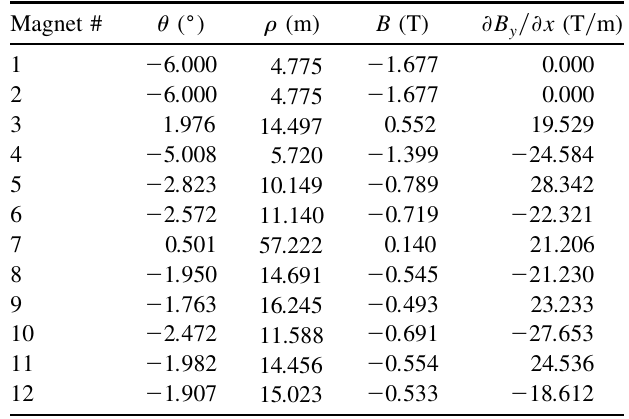
TABLE I. Bending angles (cid:3) , bending radii (cid:4) , dipole fields B , and quadrupole strengths @B y =@x of the magnets in the first half of the outward-bending superperiod. The parameters are defined with respect to the channel’s nominal axis coinciding with the 2 : 4 GeV =c reference